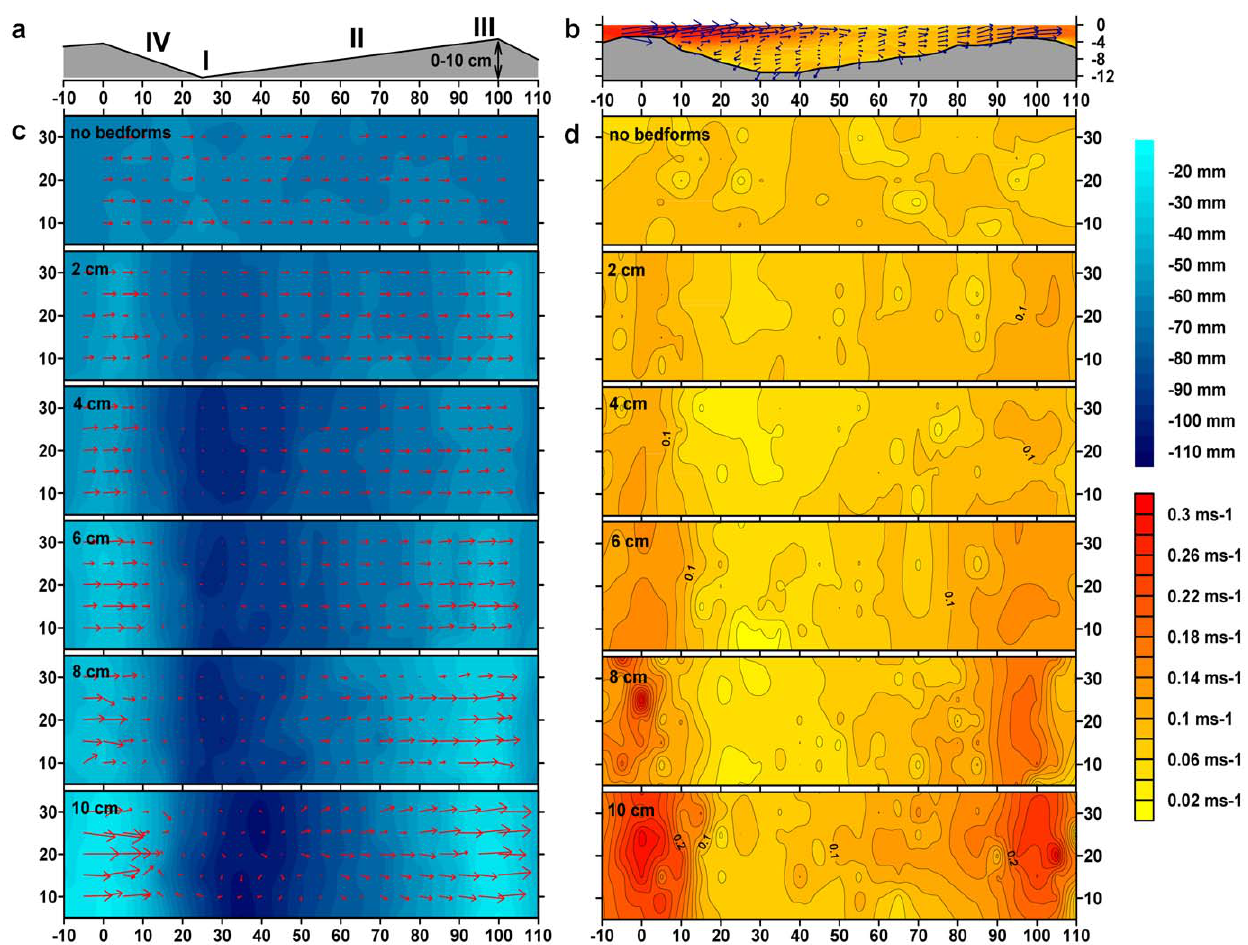
Figure 1. Constructed landscapes differing in flow heterogeneity. Graphs describe shape of and hydrodynamic conditions over approximately one bedform (38 per flume). X-axis represents longitudinal flume dimension (equivalent to main flow direction, total flume length 40 m) with distances given in cm. ( a ) Side-view of impermeable 1-m-long bedform lining the bottom of the mesocosm. Bedforms of variable height (2–10 cm) were used to create the heterogeneity gradient. I, II, III and IV show the positions (‘‘microhabitats’’) of ceramic coupons used for determination of biomass and T-RFLP. ( b ) A representative vertical cross section along the thalweg in the flume with 8 cm bedforms showing water velocity conditions above a single bedform. Y-axis represents depth below water surface (in cm), contours show length of velocity vector, blue arrows show amount and direction of current. ( c ) and ( d ) show contour plots of depth (c, blue) and velocity (d, length of 3-D vector R xyz , yellow-orange) above a single bedform in each of the 6 heterogeneity treatments, Y-axis represents lateral flume dimension (distances in cm, total flume width 0.4 m) and red arrows show amount and direction of current.